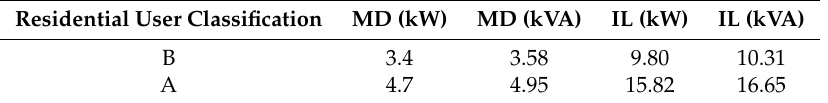
Table 2. Reference values for maximum demand and installed load of residential